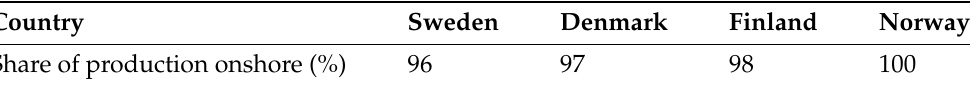
Table 11. The share of wind power production that was land-based in the Nordic countries in 2018.